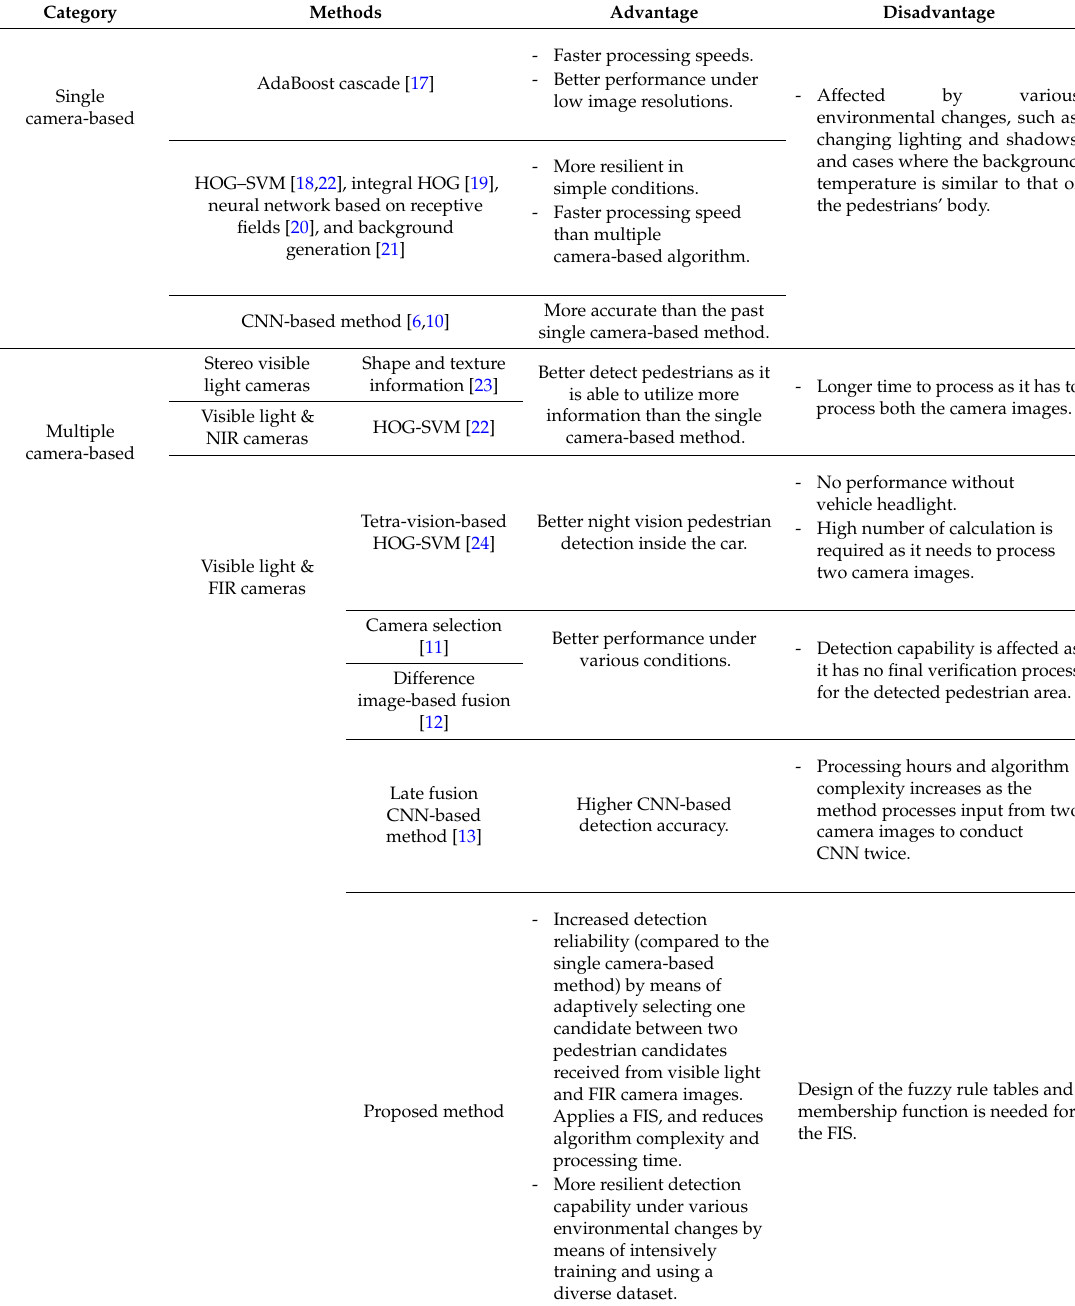
Table 1. Comparisons of the proposed and the previously researched methods.